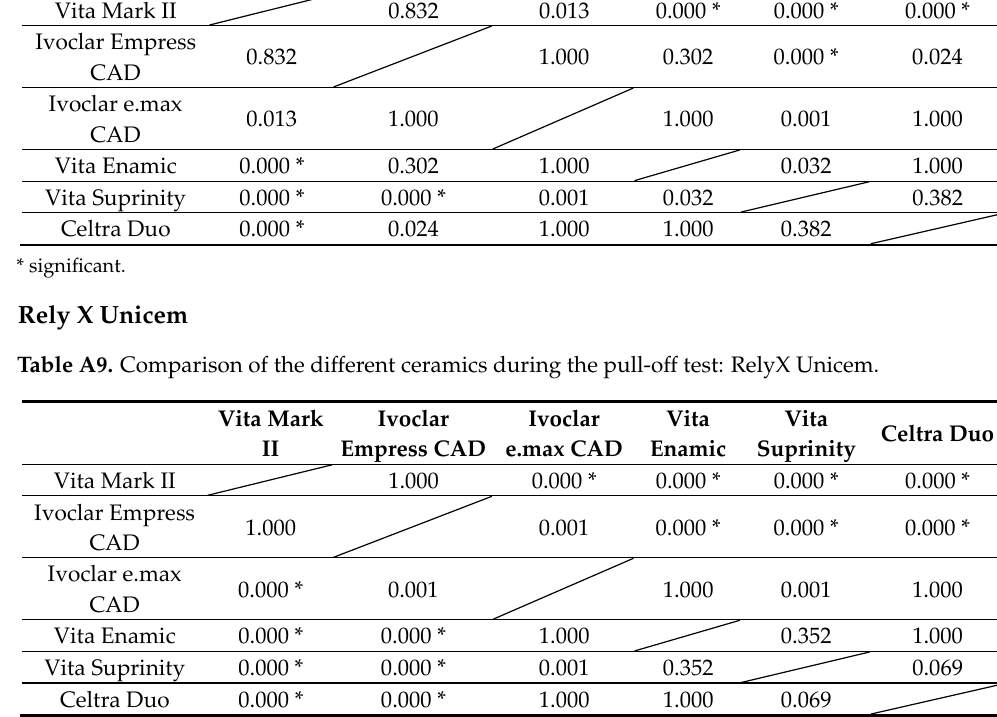
Table A10. Comparison of the different ceramics during the pull-off test: Fuji Cem.